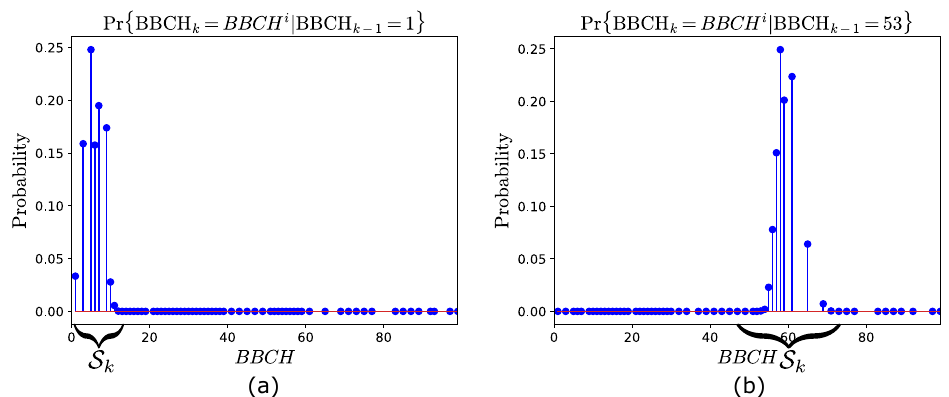
Figure 2. Prediction model obtained from the training years 2009–2019. Transition probabilities at time t k = t k − 1 + 6, given that ( a ) BBCH = 1, and ( b ) BBCH = 53 at time t k − 1 . The states space S k is also